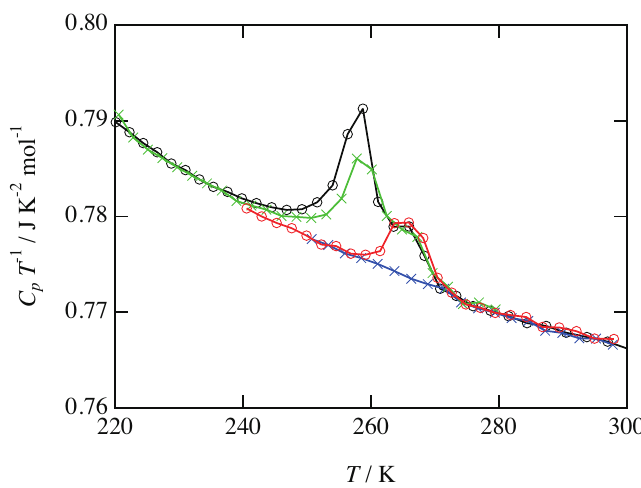
Figure 3. Experimental heat capacities divided by temperature of crystalline D -sorbose. Black, data obtained in the run from 6 K; green, data from 220 K; red, data from 240 K; blue, data from 250 K. Table 1. Thermodynamic quantities associated with the phase transition of crystalline sorbose. T trs (K)